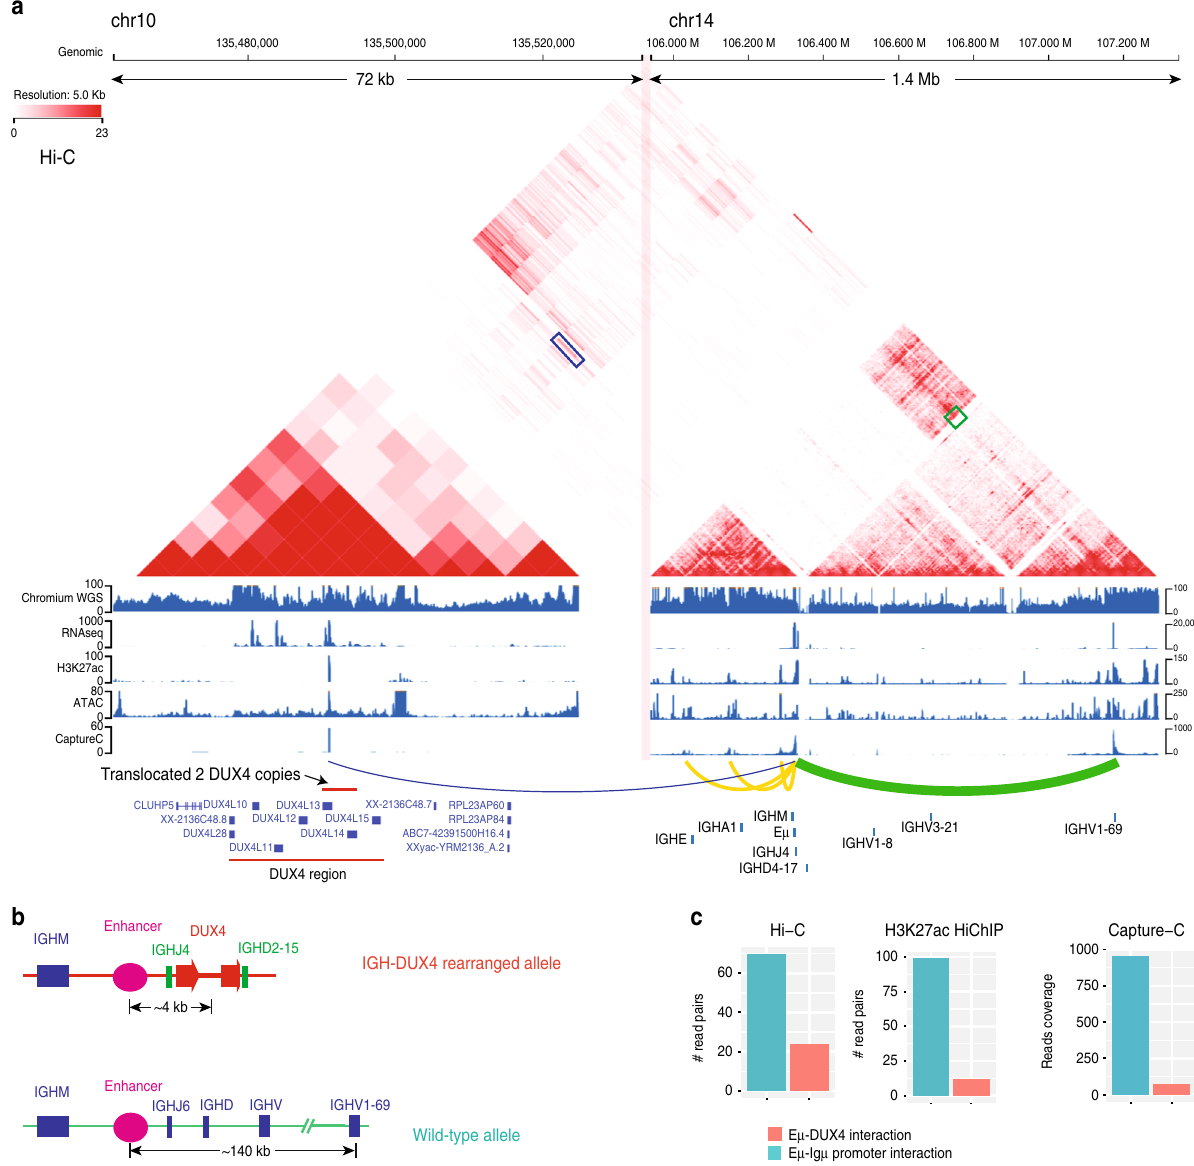
Fig. 3 Allelic speci fi city of enhancer – promoter interaction in IGH - DUX4 haplotype versus wild-type haplotype in Nalm6. a Chromatin interaction plot from Hi-C data at the DUX4 region (72 kb) on 10q26 and the IGH region (1.4 Mb) plotted by the ProteinPaint program 43 . Different y -axis scale was used at DUX4 and IGH region for plotting RNA-seq, H3K27ac, ATAC-seq, and Capture-C. The E μ - DUX4 interaction and E μ -Ig μ promoter interaction are marked as a blue and green box, respectively. In Capture-C data, the colored arcs represent regions interacting with E μ , with thickness indicating interaction intensity. Yellow arcs show known E μ -Ig μ interactions. The two translocated DUX4 copies were marked at DUX4L13 region, because this region is best matched to our assembled IGH-DUX4 haplotype. Details are in Methods section. b Diagrams of E μ - DUX4 interaction and E μ -Ig μ promoter interaction in different alleles. The genomic distances were estimated based on Chromium WGS data and the knowledge that the functional Ig μ is from the active IGH allele which undergoes VDJ recombination 3 . Details are in Methods section. c Comparison of supporting read pairs for Hi-C/H3K27ac HiChIP, the reads coverage for Capture-C between E μ - DUX4 interaction and E μ -Ig μ promoter interaction. Multiple mapping issue at DUX4 regions was considered. The details